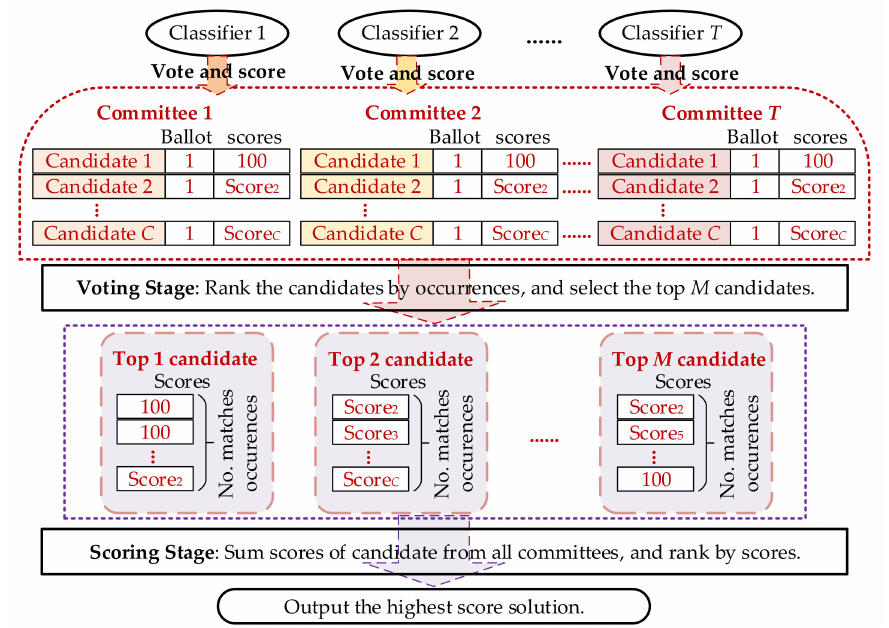
Figure 2. Two-stage decision-making process for combined